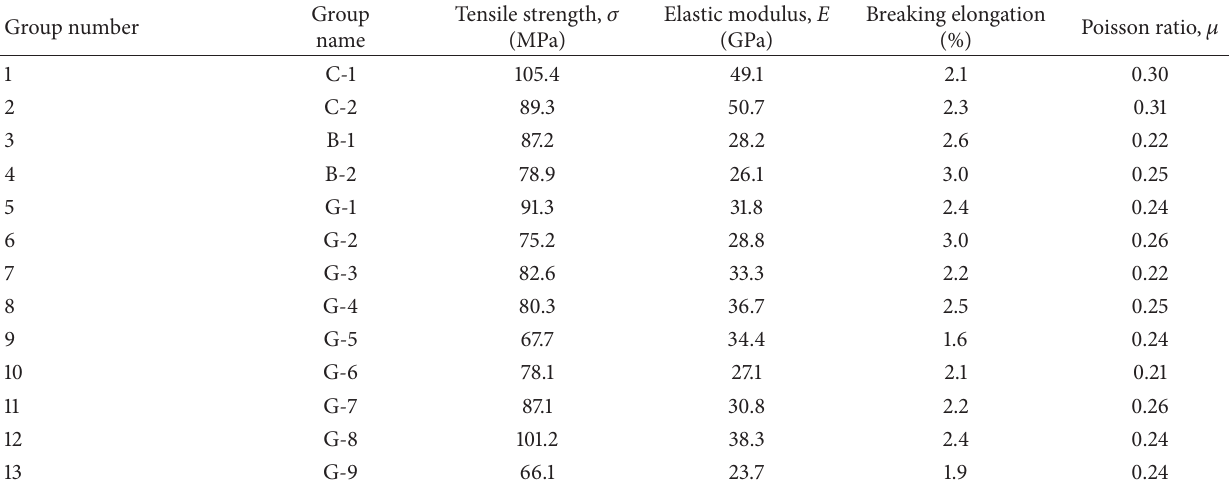
Table 4: Summary of tensile properties of sprayed FRP.